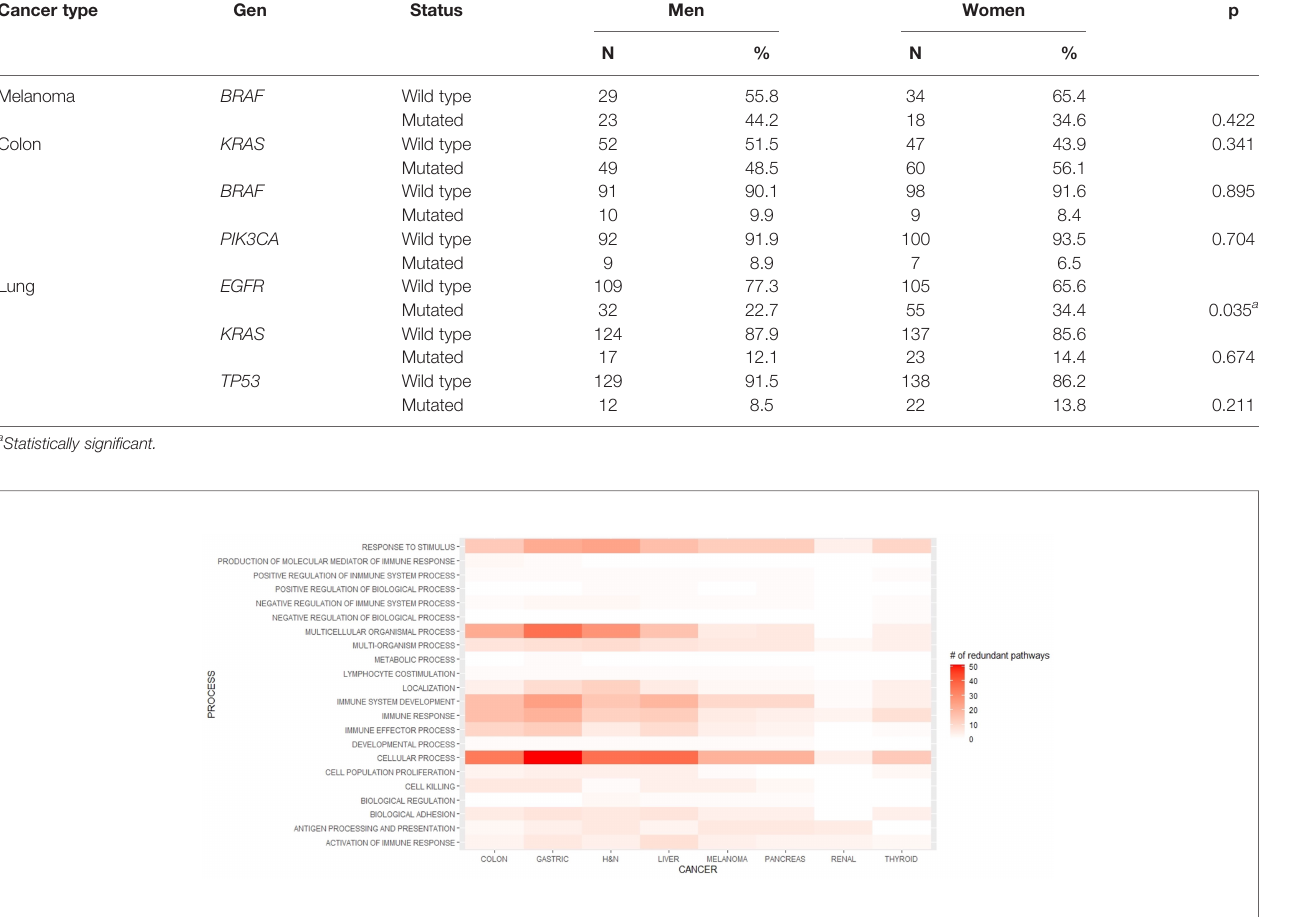
FIGURE 3 | Enriched immune processes in each cancer type in